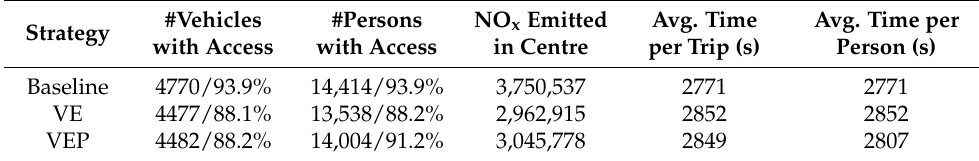
Table 1. Simulation results for parking access with constant arrival rates.